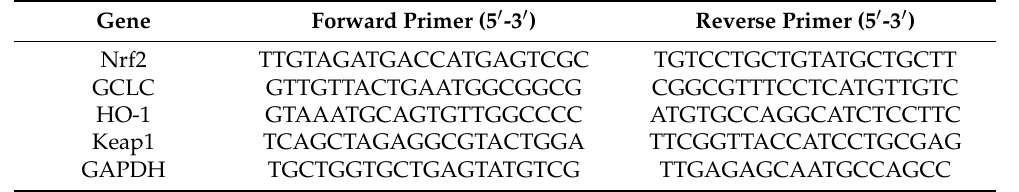
Table 1. Primers used for qRT-PCR. Gene Forward Primer (5 (cid:48) -3 (cid:48) ) Reverse Primer (5 (cid:48) -3 (cid:48)